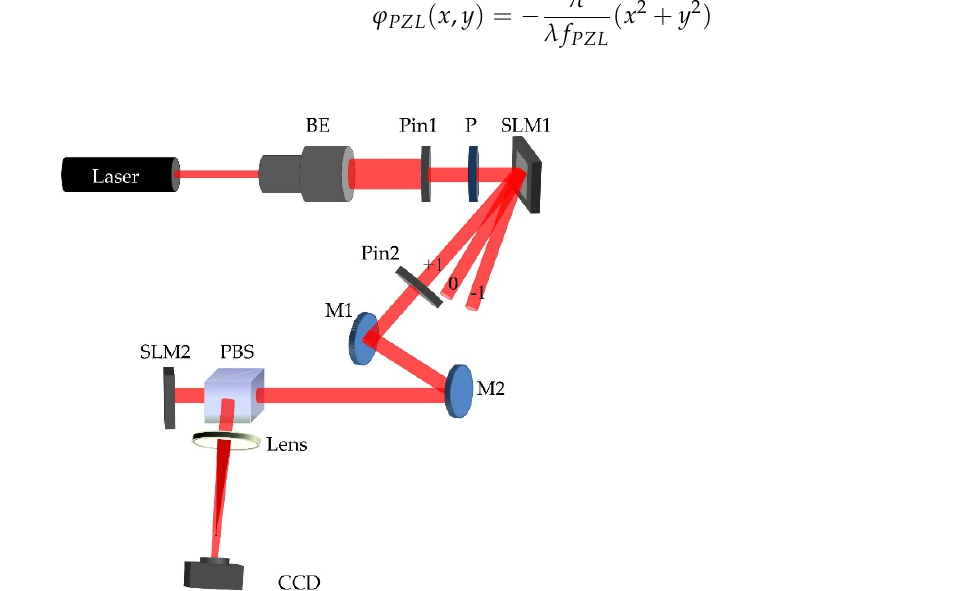
Figure 5. Schematic diagram of the experimental setup of composite OAM phase holography. BE: beam expander; Pin: pinhole aperture; P: linear polarizer; PBS: polarizing beam splitter; SLM: spatial light